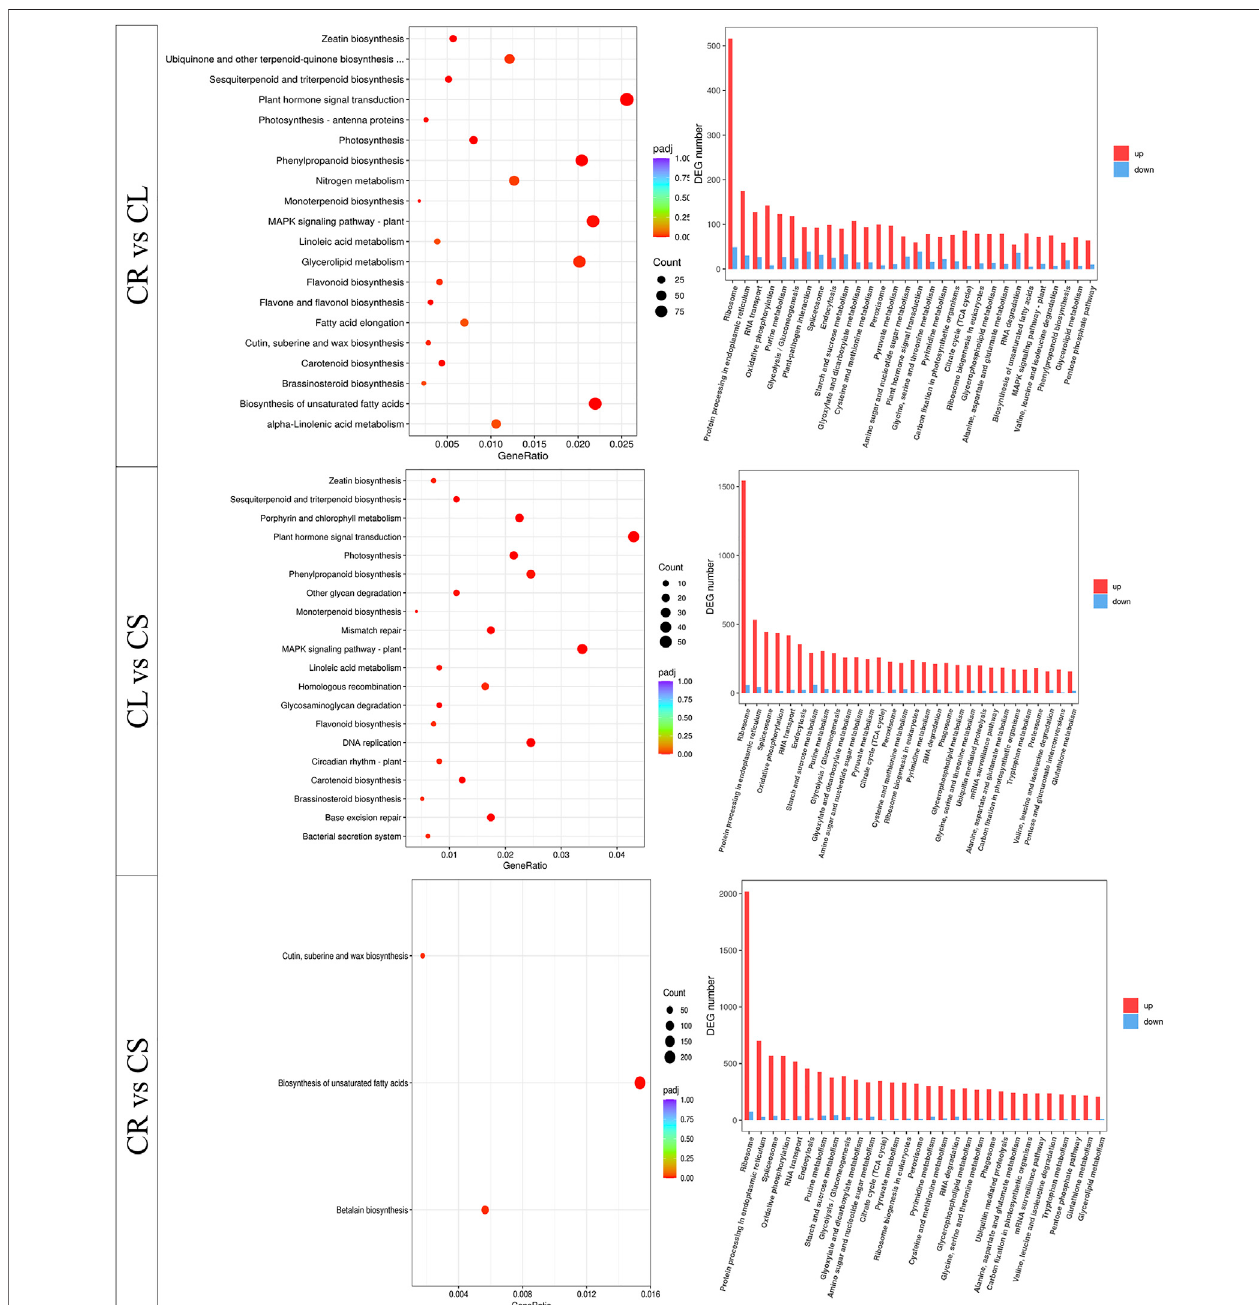
FIGURE 6 | KEGG pathway enrichment analysis of the differentially expressed genes between leaf (CL), stem (CS), and tuber (CR) in C. convolvulacea.